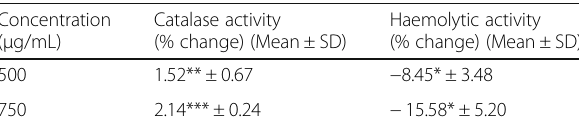
Table 1 Effect of PF on catalase and haemolytic activity of P.